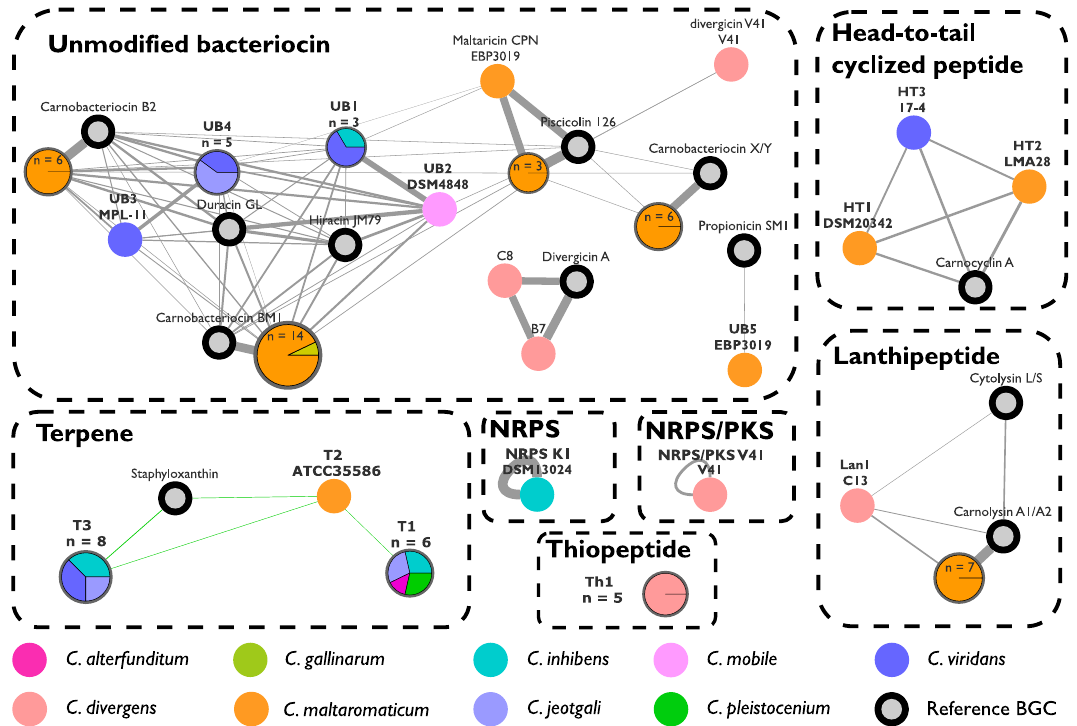
Figure 3. Sequence similarity network of Carnobacterium predicted biosynthetic gene cluster (BGCs). The network was generated with BiG-SCAPE, and graphical modifications were done with Cytoscape. A node represents a predicted BGC. For more legibility, several similar BGCs were grouped into a single node. In this case, a pie chart illustrates the represented species, and the size of the node is proportional to the number of BGCs. The thickness of the lines is correlated to the similarity between two nodes. The dotted boxes indicate the different classes of BGCs.